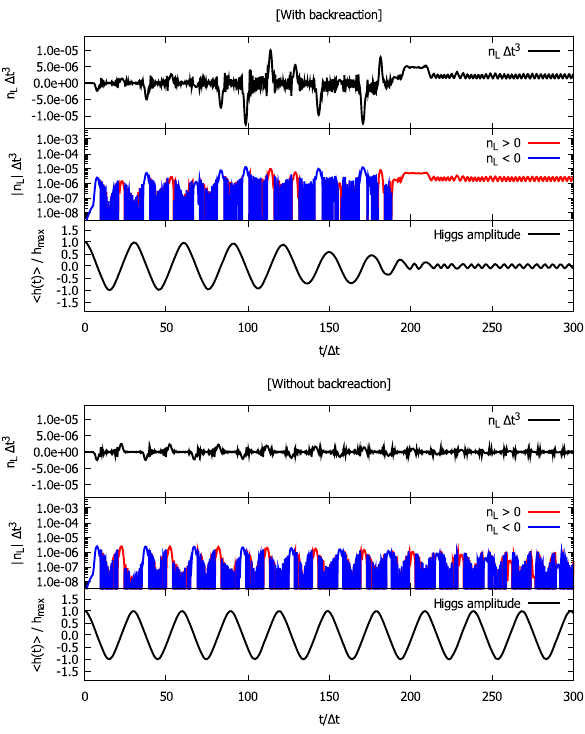
Fig. 1 Upper: the time evolutions of the lepton number in a volume of (cid:16) t 3 and the amplitude of the Higgs background. The parameters are set by (cid:4) h ( t 0 ) (cid:5) = 10 16 GeV and M 1 = 10 17 GeV. The first two figure shows the time evolution of the net lepton number with normal and logarithmic scales of the vertical axes. The third figure shows the time evolution of the Higgs amplitude. Lower: the time evolutions with the same parameters to the upper panel but without the backreaction effect ( J BR = 0 in